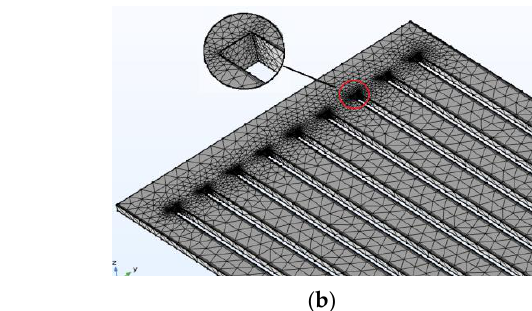
Table 3. Accuracies and ranges of testing devices.